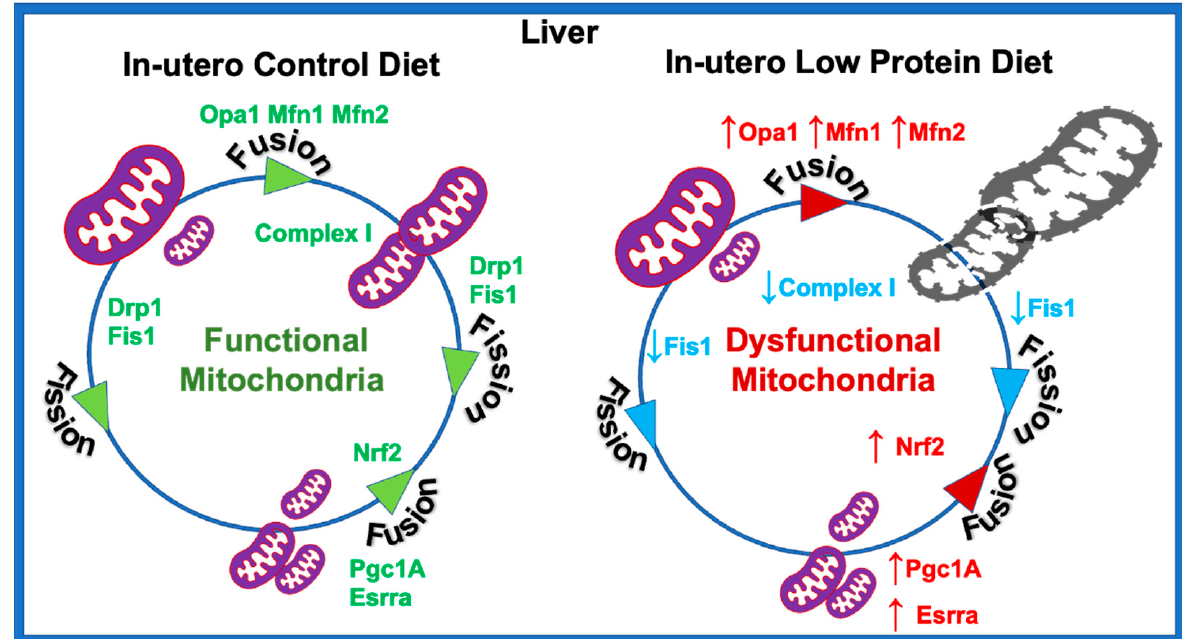
Figure 7. Schematic representation of the molecular mechanism of in utero low protein programmed mitochondrial